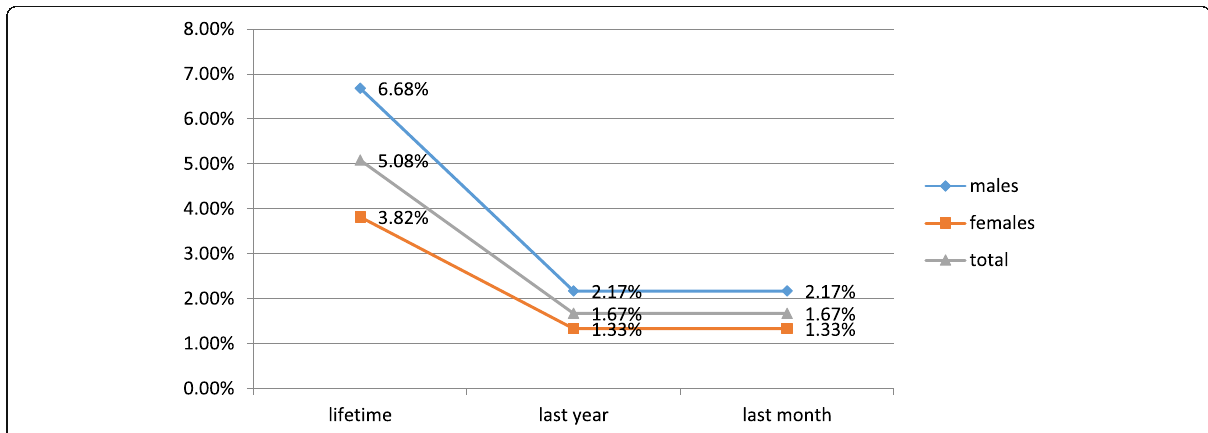
Fig. 3 Self-reported lifetime, last 12 months, and last 30 days prevalence of tranquilizer (BDZ)